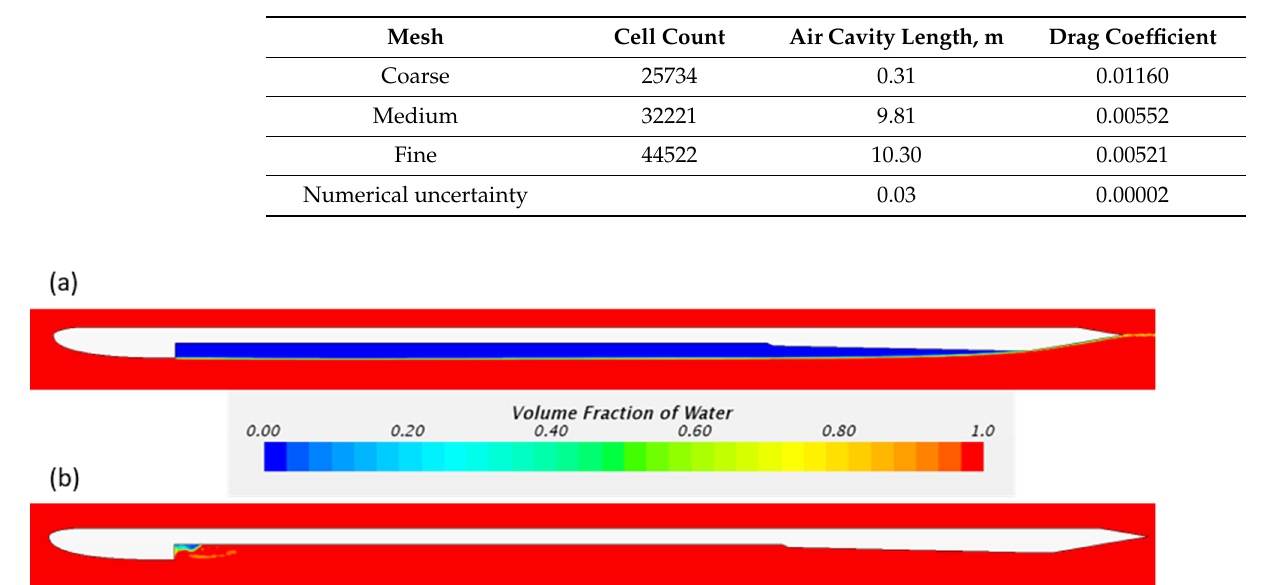
Table 1. Results obtained in mesh-dependency study at q = 0.016 and U = 5.4 m/s.